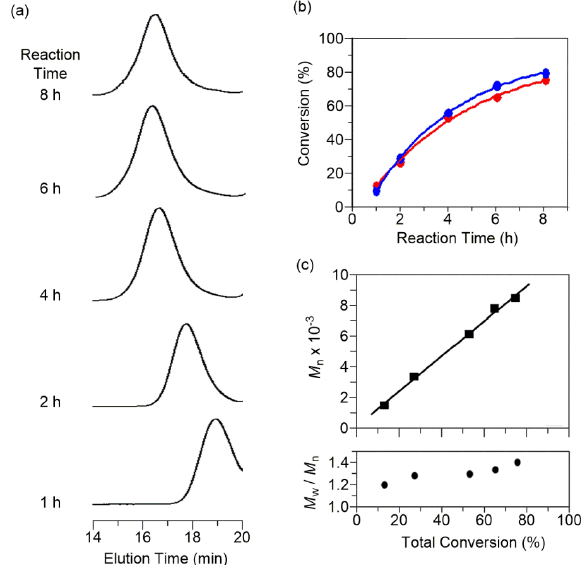
Figure 1. Size exclusion chromatography (SEC) curves of poly(DEGV- alt -EtMI) obtained by radical copolymerization ( a ) without and ( b ) with RAFT agent using THF as the eluent.